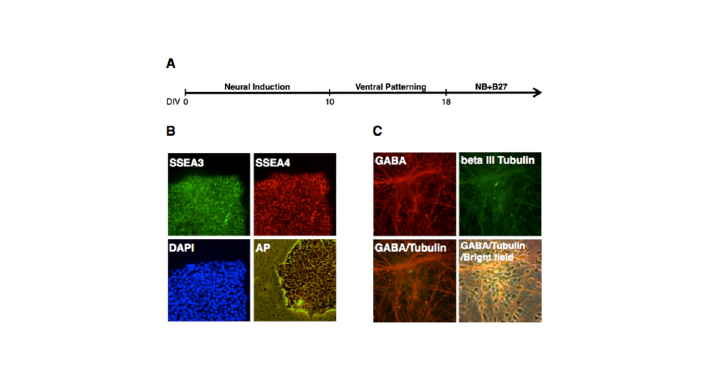
(using a fluorescent substrate for AP for characterizing pluripotent stem cells) of H1 colonies before neuronal differentiation. C. Immunostaining of hESCs-derived neurons at days in dish (DIV) 32 using antibodies reacting with GABA and beta III tubulin, which are the biomarkers for GABA neurons.